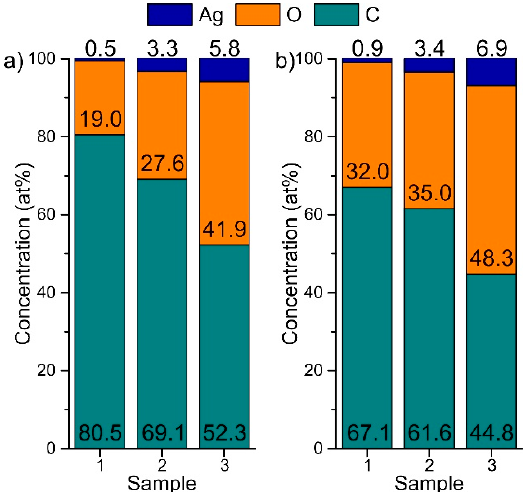
Figure 5. Chemical composition of DLC:Ag films (Samples 1–3) after 5 s ( a ) and 20 s ( b ) of O 2 plasma processing.